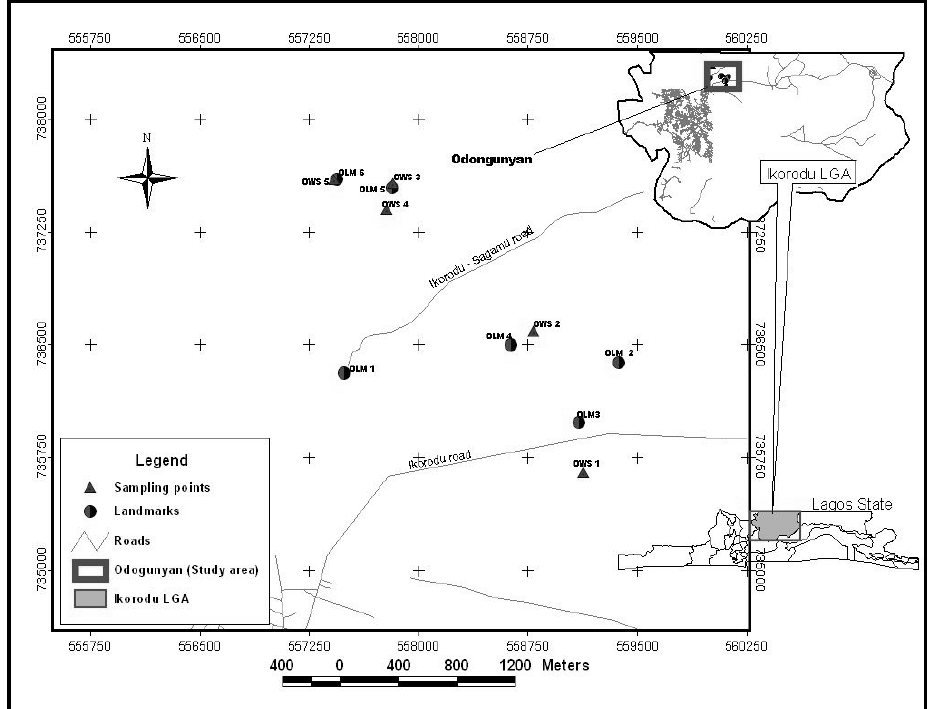
Figure 1. Sampling points in the study